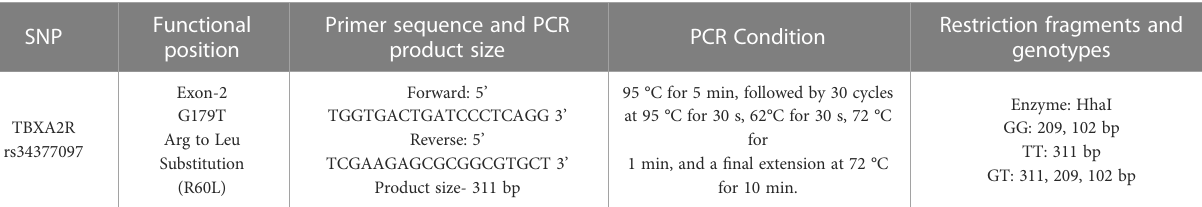
TABLE 1 PCR Conditions and restriction fragments of TBXA2R rs34377097